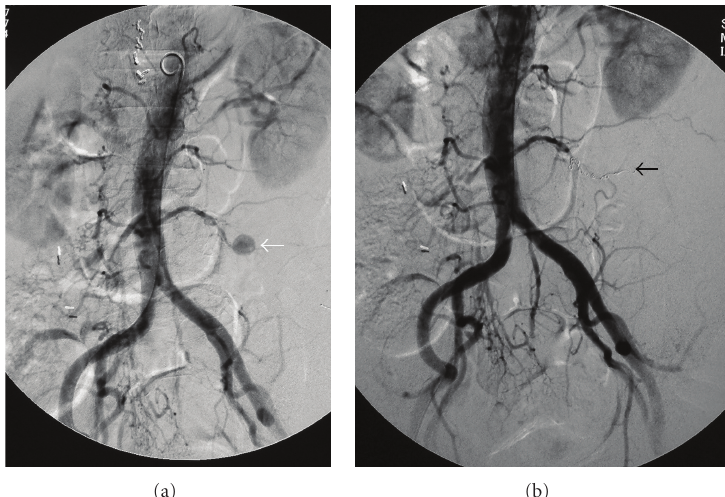
Figure 3: (a) Angiogram revealed a pseudoaneurysm of left fourth lumbar artery (white arrow). (b) The pseudoaneurysm was treated with transcatheter placement of microcoils into the left fourth lumbar artery (black arrow).